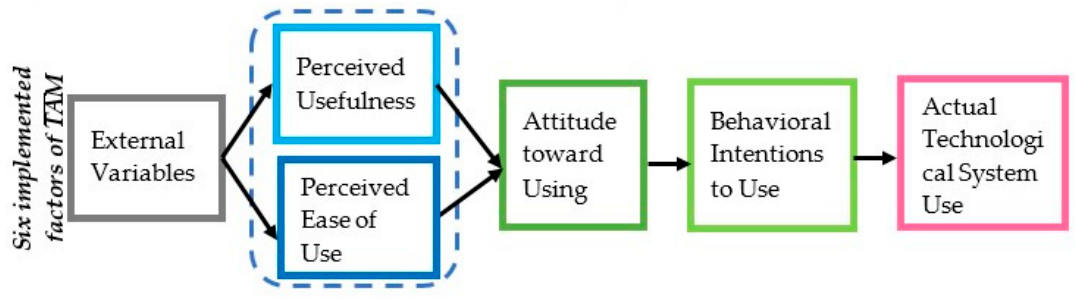
Figure 2. Technology acceptance model (TAM) model.